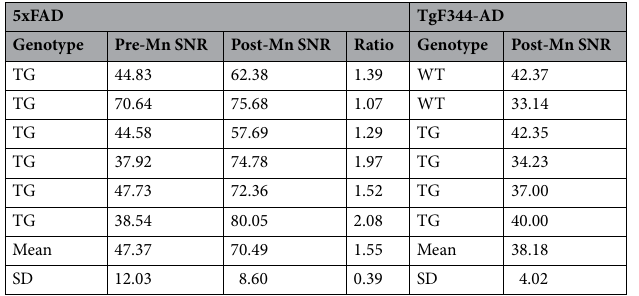
Table 2. Signal-to-noise ratios of MGE magnitude meanTE images. MGE multi-gradient-echo, meanTE average across all echo times, SNR signal-to-noise